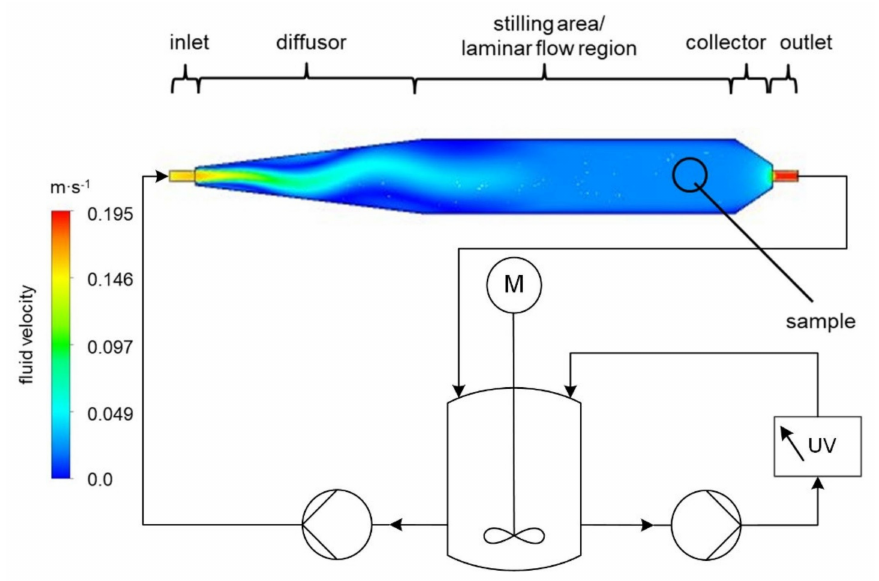
Figure 2. Experimental setup of the flow channel dissolution apparatus for a Reynolds number of 250.